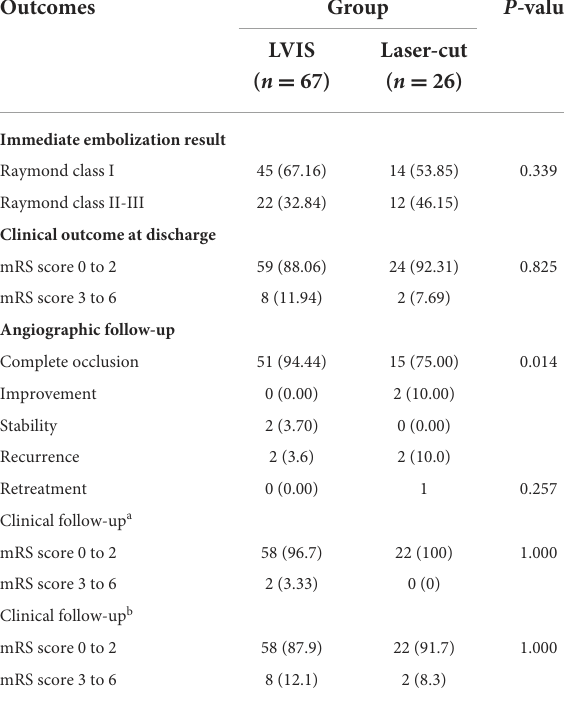
TABLE 3 Angiographic and Clinical Outcomes for patients treated with LVIS and laser-cut stent. Outcomes